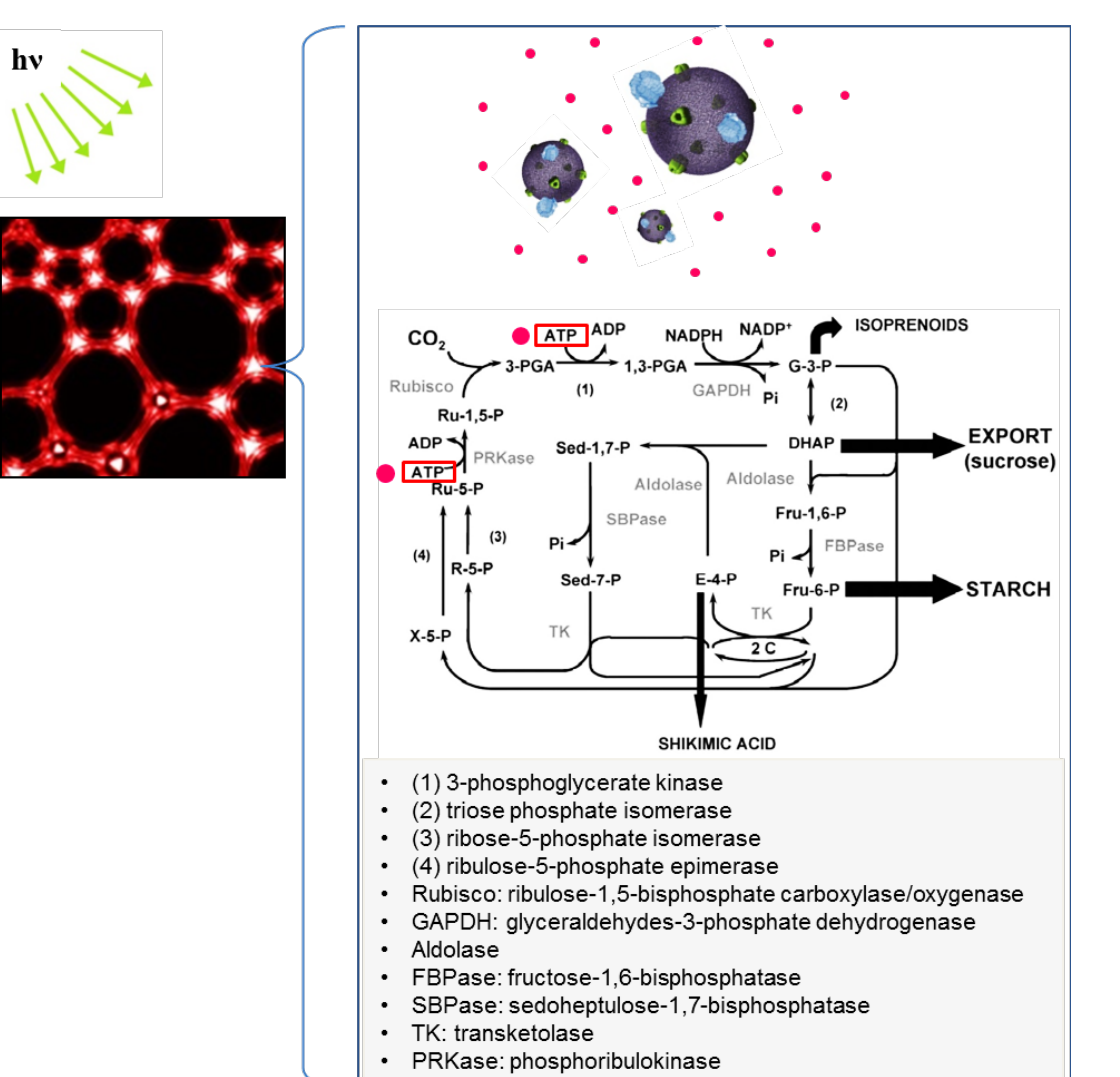
Figure 13. Application of ATP-producing polymersomes to replicating the artificial Calvin cycle in the foam to produce biofuels and carbon fixation. The Calvin cycle diagram is adapted with permission from [152]. Copyright 2003 Springer Science and Business